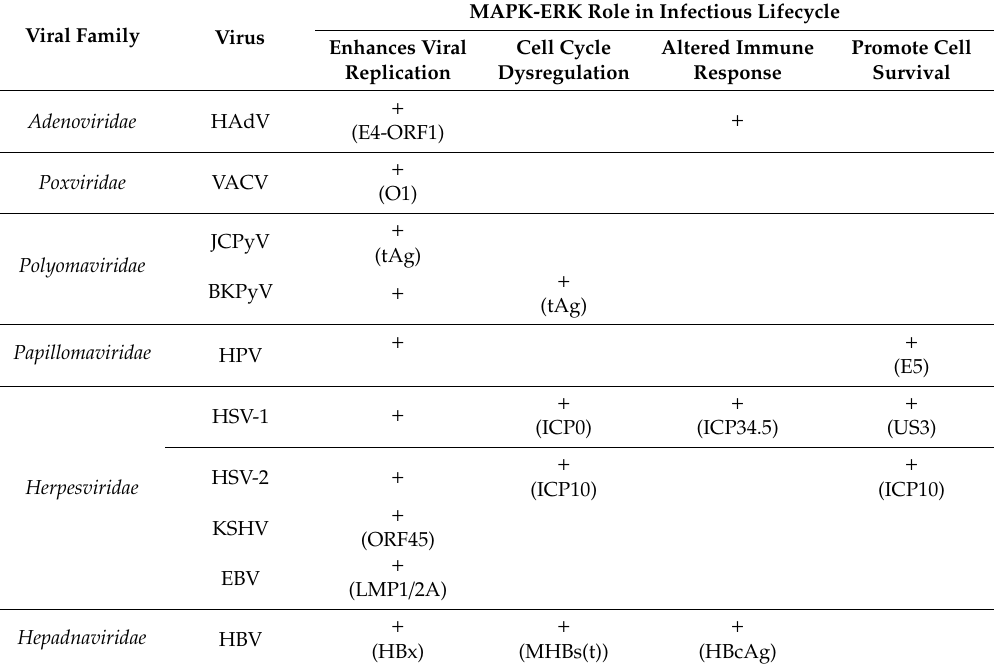
Table 1. Role of MAPK-ERK in infectious lifecycle of DNA viruses. ( + ) indicate viral induction of the MAPK-ERK pathway to facilitate the indicated response, with the associated viral protein that influences MAPK-ERK signaling indicated (if